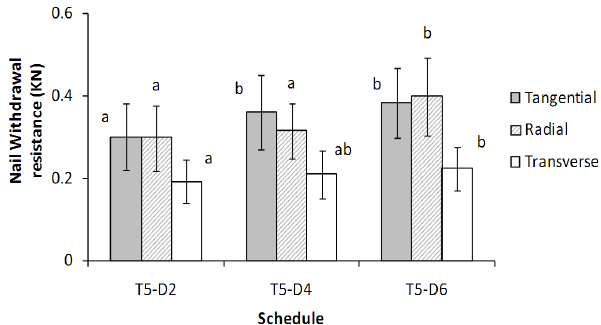
Fig. 4. Nail withdrawal resistance in tangential, radial, and transverse surfaces of samples dried under the three adopted kiln